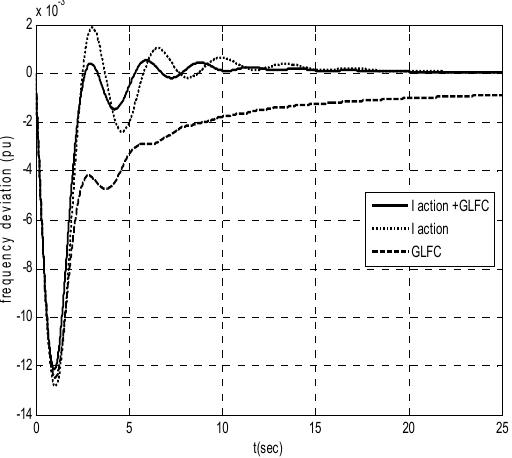
Figure 5. The frequency deviation response in area 1. (at step load change of 187.5 MW in area 1)